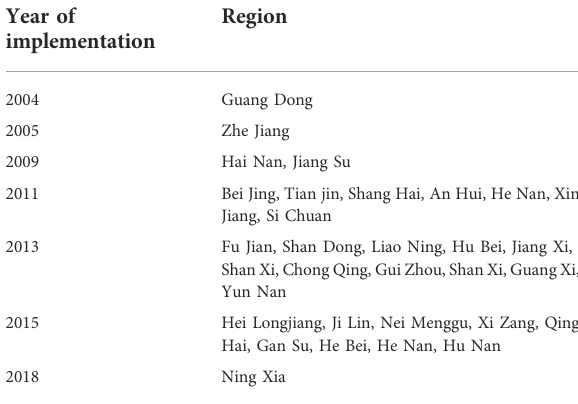
TABLE 1 Year of implementation of PBB reform by